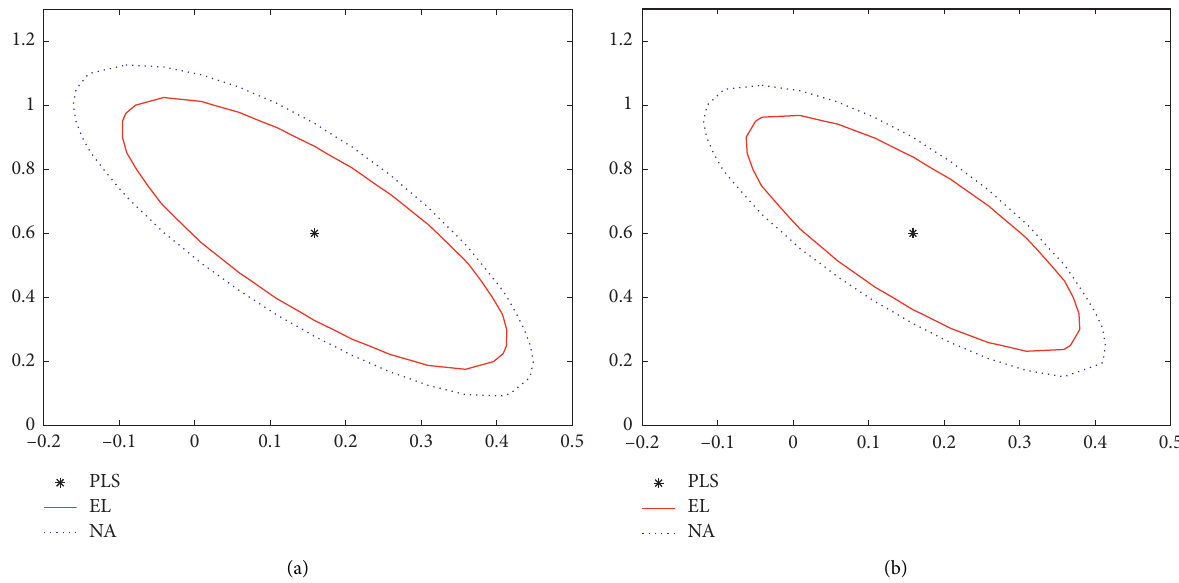
Figure 3: The confidence regions of ( θ